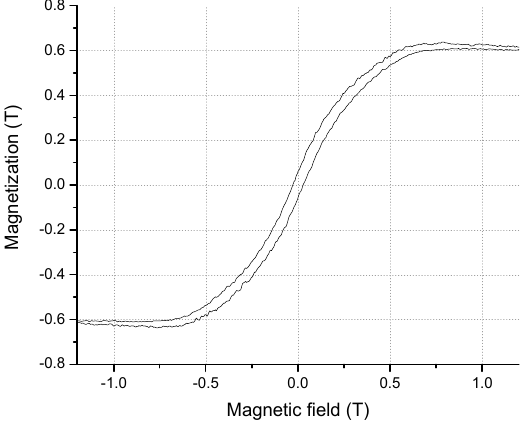
Figure 3. In-plane magnetization measurement of the Tb x Dy (1 − x) Fe y film using vibrating sample magnetometer (VSM).